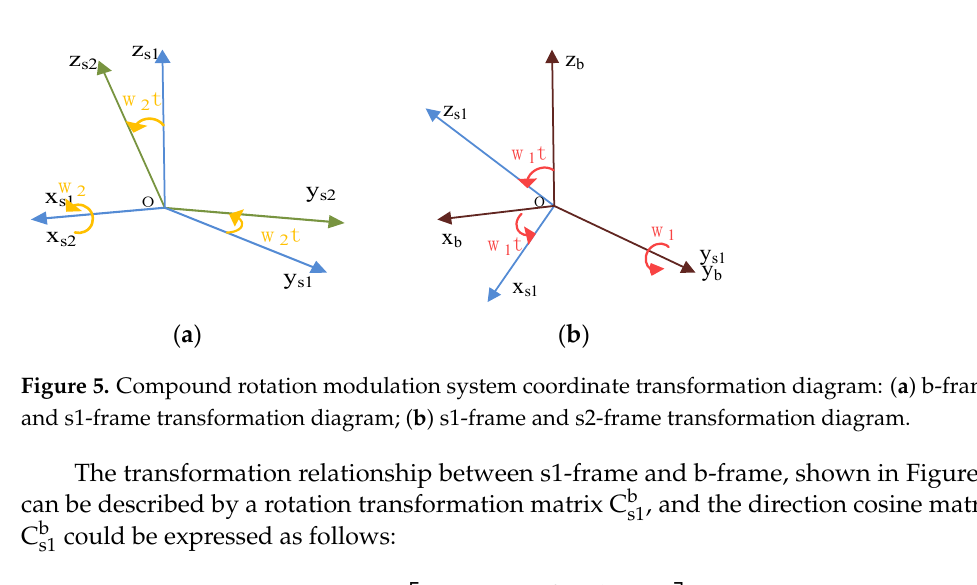
Y b Y S o w 1 t Figure 4. Schematic diagram of biaxial rotating IMU configuration. In Figure 4, one IMU is placed on rotating platforms, combined with a small rotat- ing platform and strapdown with the large rotating platform. The IMU rotates around the axis of the smaller rotating platform while following the rotation of the larger rotat- ing platform. The IMU is driven by a small rotating platform and rotates around the axis of rota- tion of a large rotating platform. IMU outputs a signal in an s2-frame, consisting of three